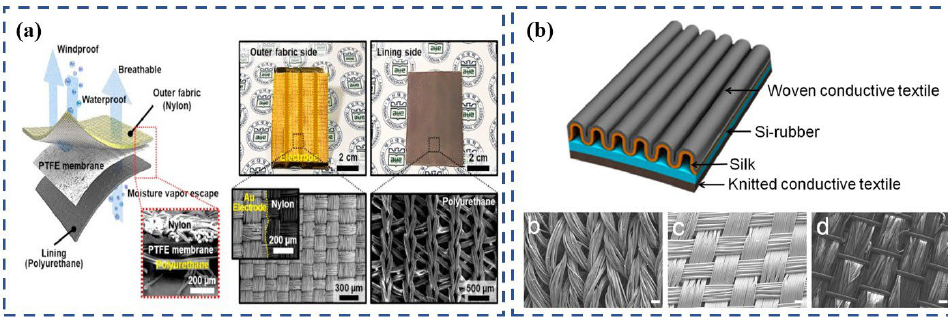
Figure 8. ( a ) Schematic of textile-TENG components (i.e., Gore-Tex); a woven-fabric composite consists of a nylon outer fabric, PTFE membrane (center layer), and polyurethane lining. Reproduced with permission [86]. Copyright 2014, Elsevier. ( b ) Corrugated textile-based triboelectric-structure generator consisting of a woven conductive textile, knitted conductive textile, and silk. Reproduced under the terms of the CC-BY Creative Commons [87].